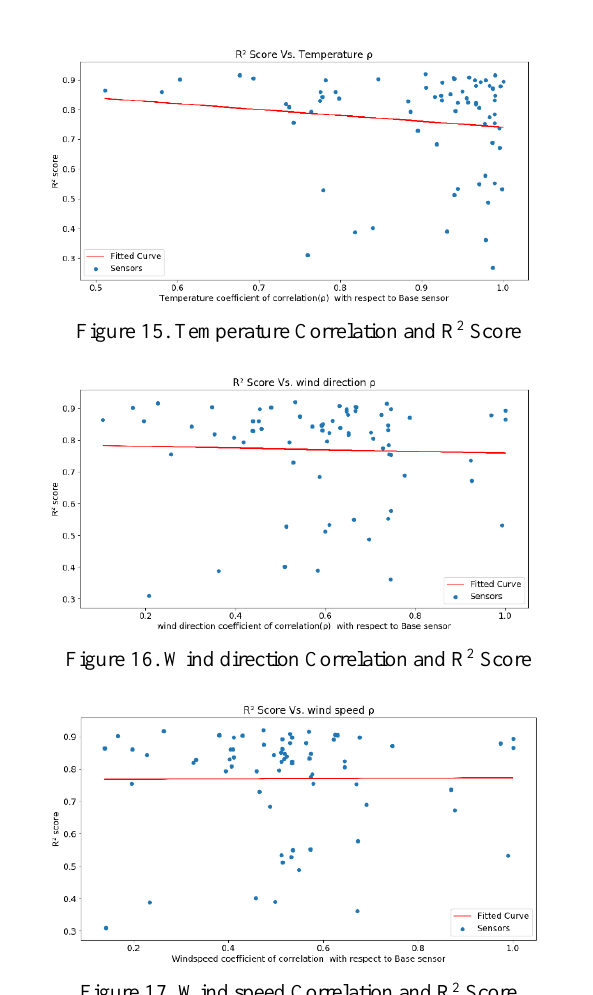
Figure 17. Wind speed Correlation and R 2